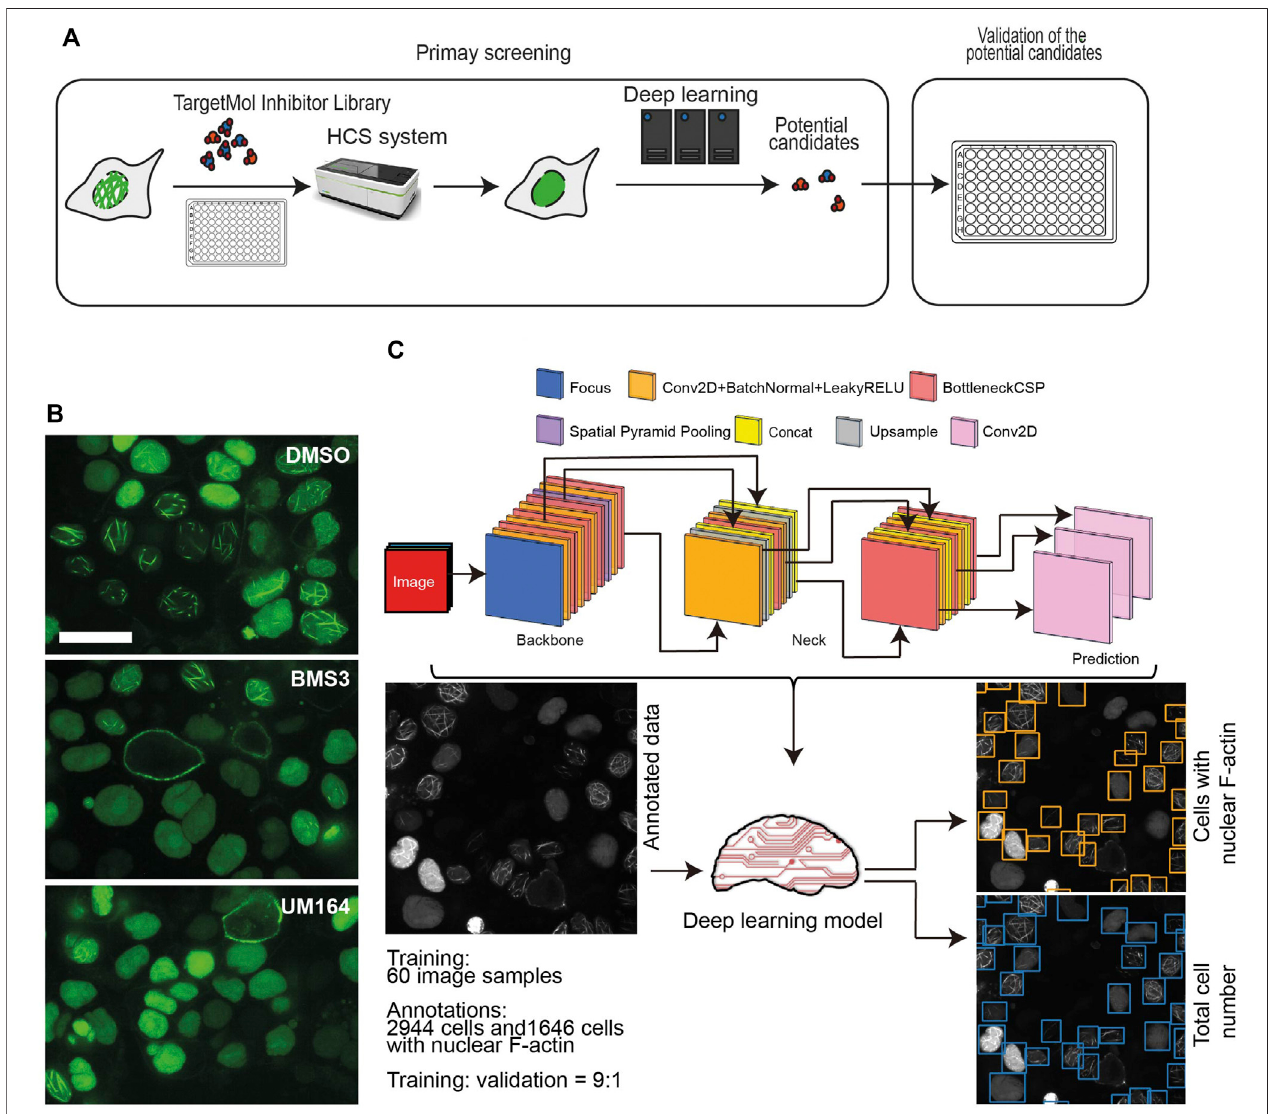
FIGURE2| High-throughputscreeningusingasmallmoleculeinhibitorlibrary. (A) ,Aschematicwork fl owshowingthehigh-throughputscreeningperformedinthe OVCA432-nAc-citrine cell line, using TargetMol small molecule inhibitor library and high-content screening followed by a deep learning approach. (B) , Representative imagesofOVCA432-nAc-citrinecellstreatedwith2.5 µMBMS3toinhibitLIM kinases,orUM164 toinhibitSrcandMAPKkinases.Cellswere fi xedand stainedafter 6 h inhibitor treatment. The images were captured using high-content screening. Green, nAc-citrine. Blue, DAPI. Scale bar, 20 µm. (C) , The deep learning pipeline